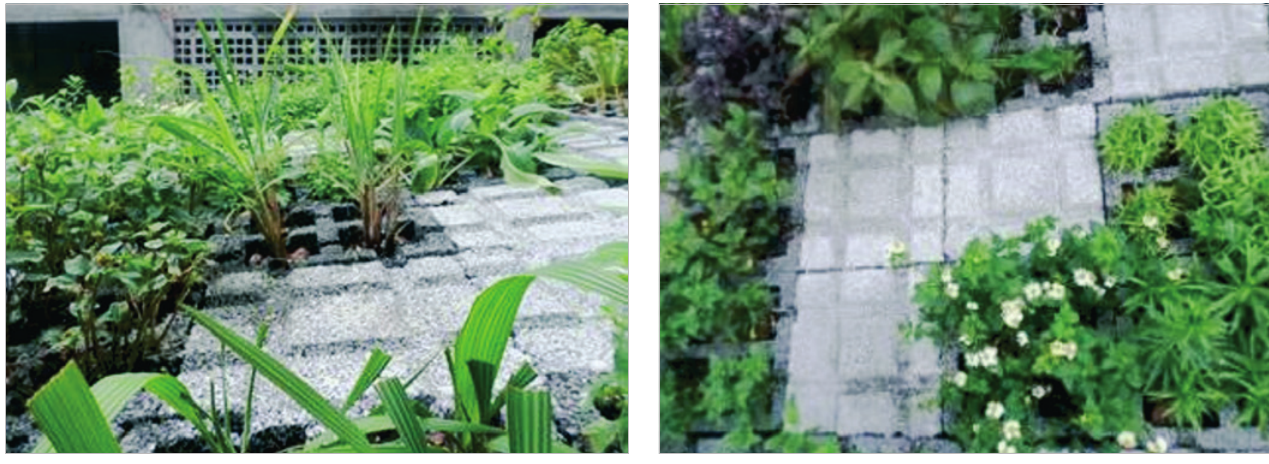
Extensive modular green roof proposed with TEVA blocks (partially vegetated